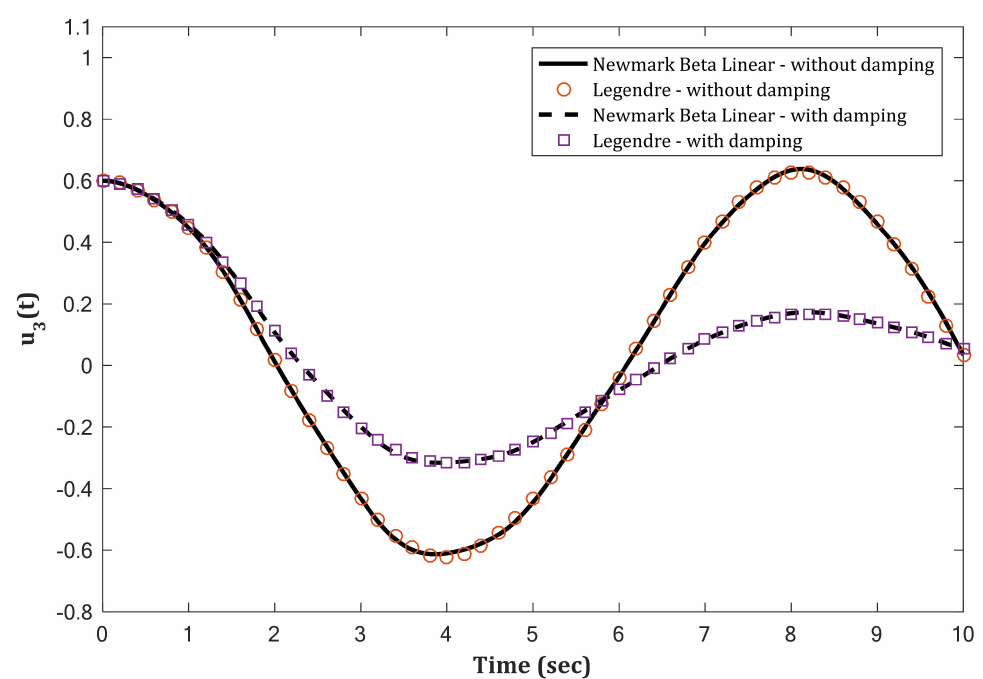
Figure 15. Free vibration analysis of a 5DOF system. Comparison of u 3 ( t ) as a function of time, as obtained using the LGM method or the linear Newmark- β method.